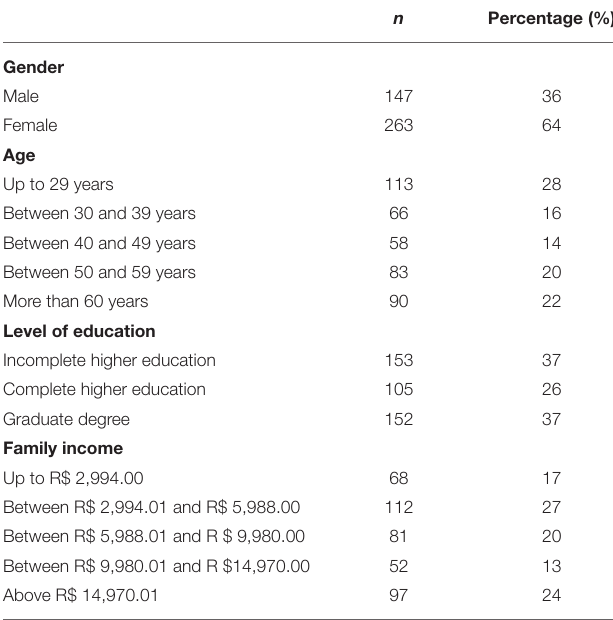
TABLE 2 | Demographic characteristics of the respondents. TABLE 3 | Descriptive statistics of meat consumption habits and intention to reduce meat